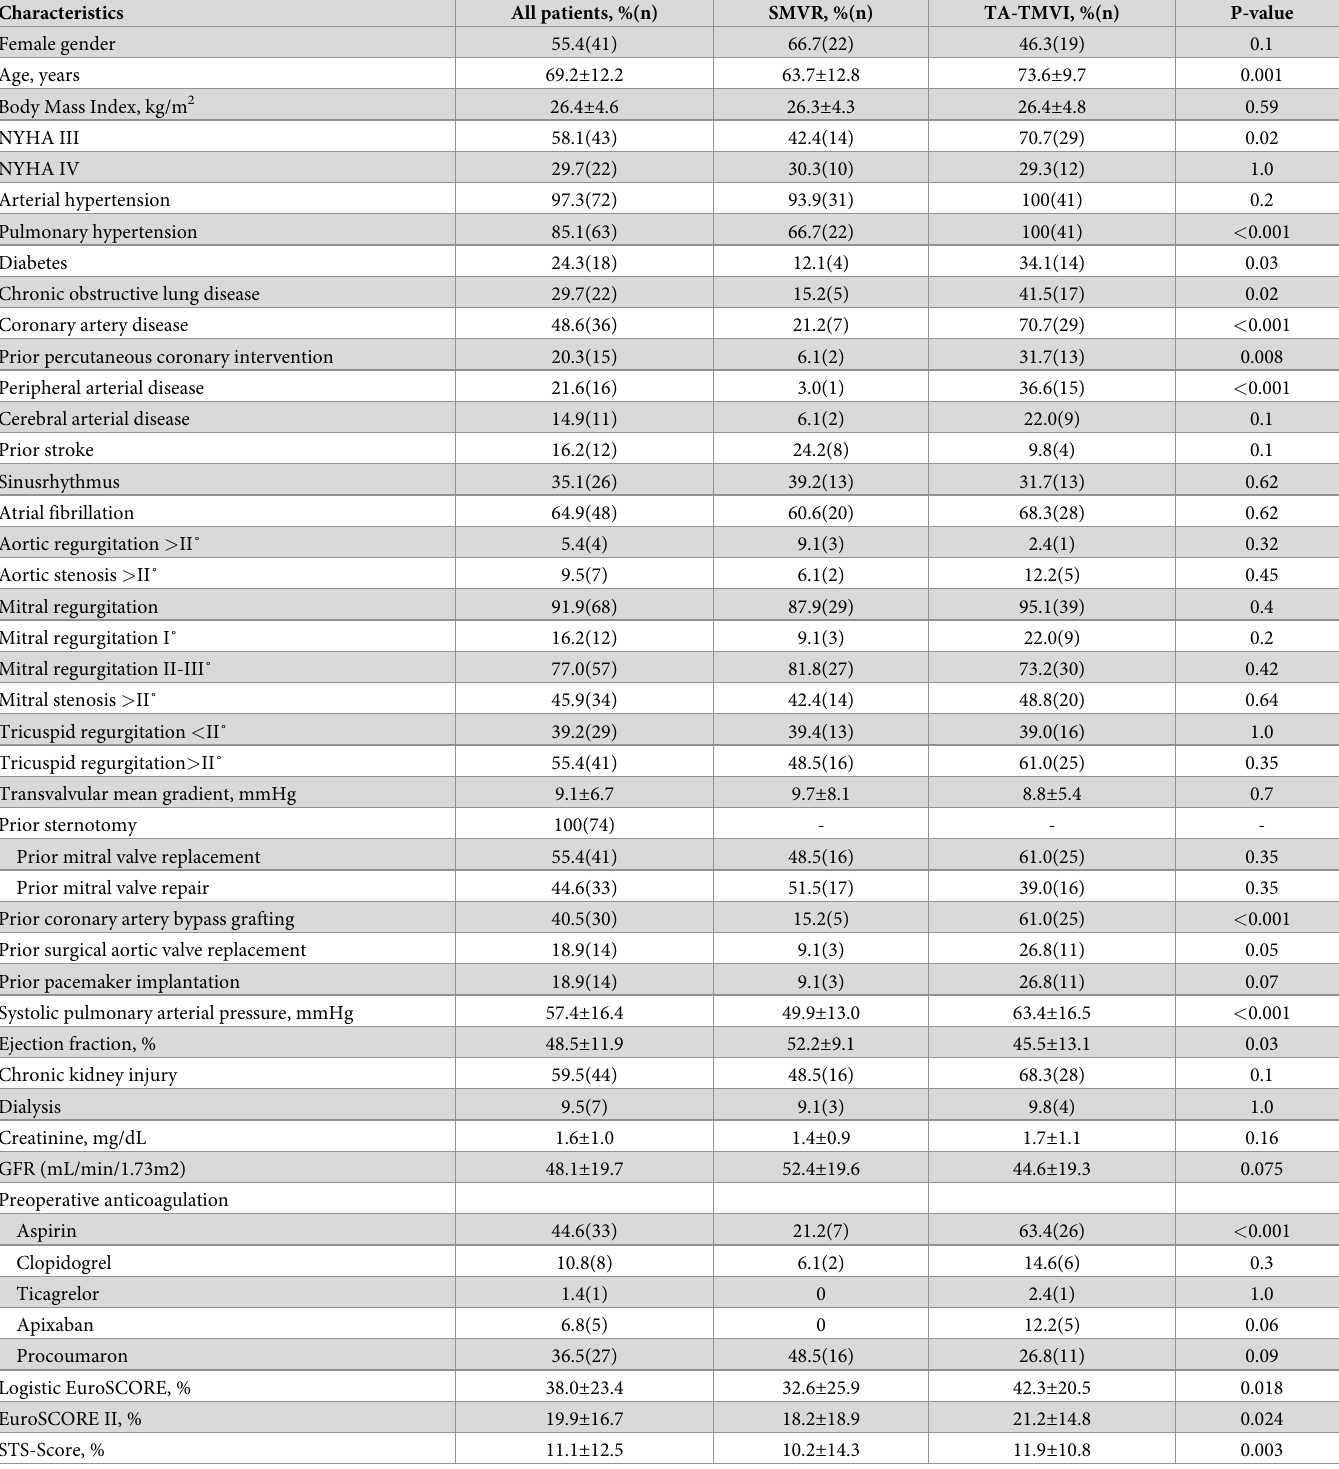
Table 1. Baseline